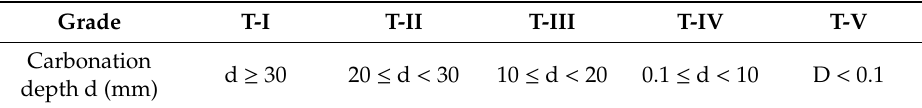
Table 9. Classification of carbonation resistance of concrete.